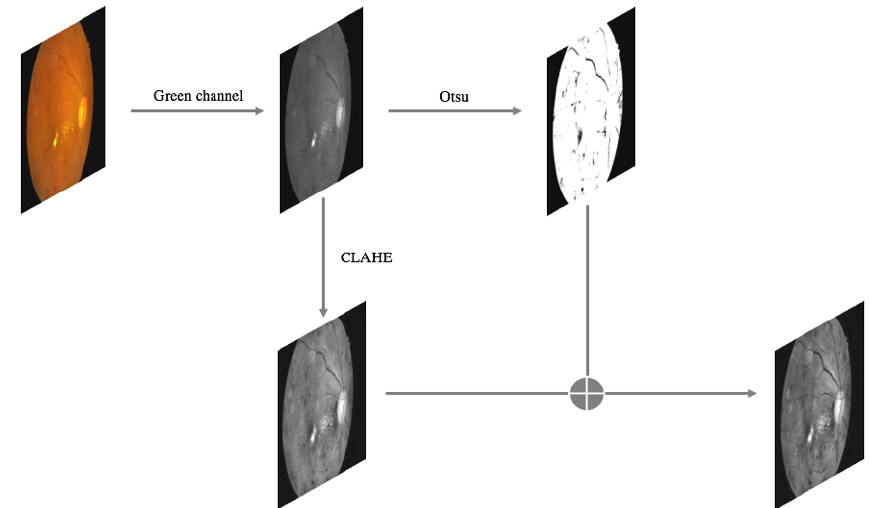
Figure 5. Overview of our image quality equalization method. The green channel of an image shows more texture information than the red and blue channels do [51,52]. The Otsu method is widely used in image processing to emphasize the differences between background and foreground, making it an effective means of enhancing image contrast